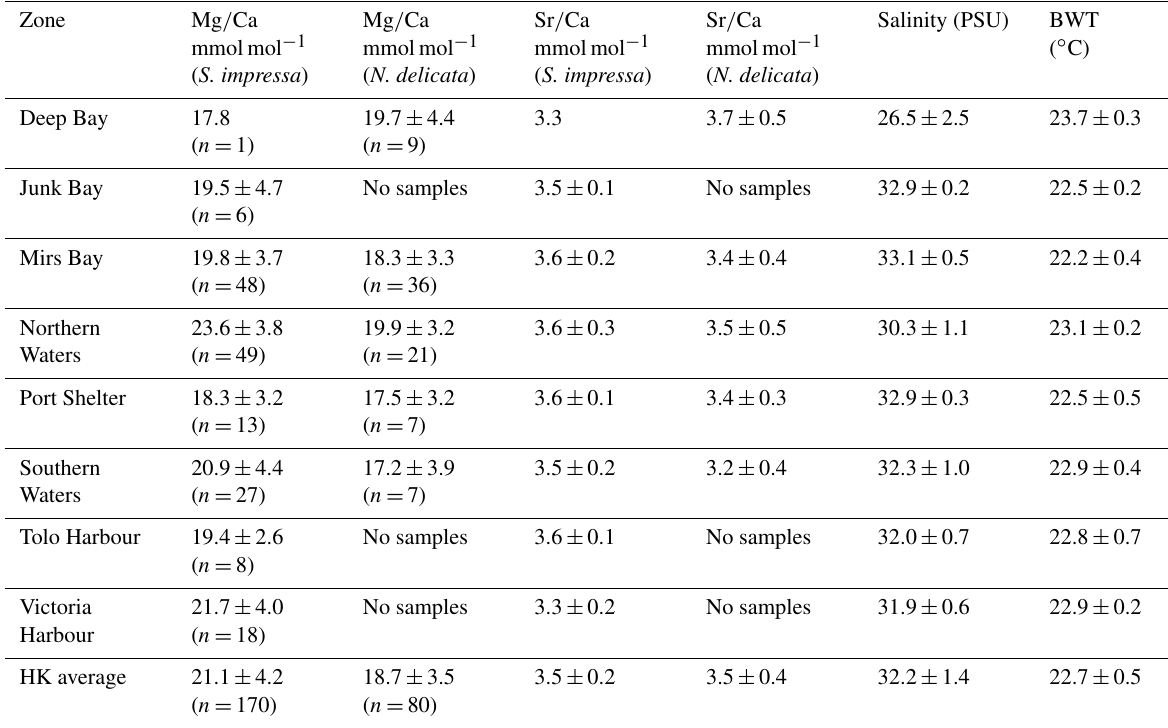
Table 2. Mean and standard deviation (1 SD) of Mg / Ca and Sr / Ca ratios of adult S. impressa and N. delicata . The number of shells for Mg / Ca and Sr / Ca are the same. Last two columns show mean and standard deviation (1 SD) of annual bottom-water salinity and temperature by water control zone of